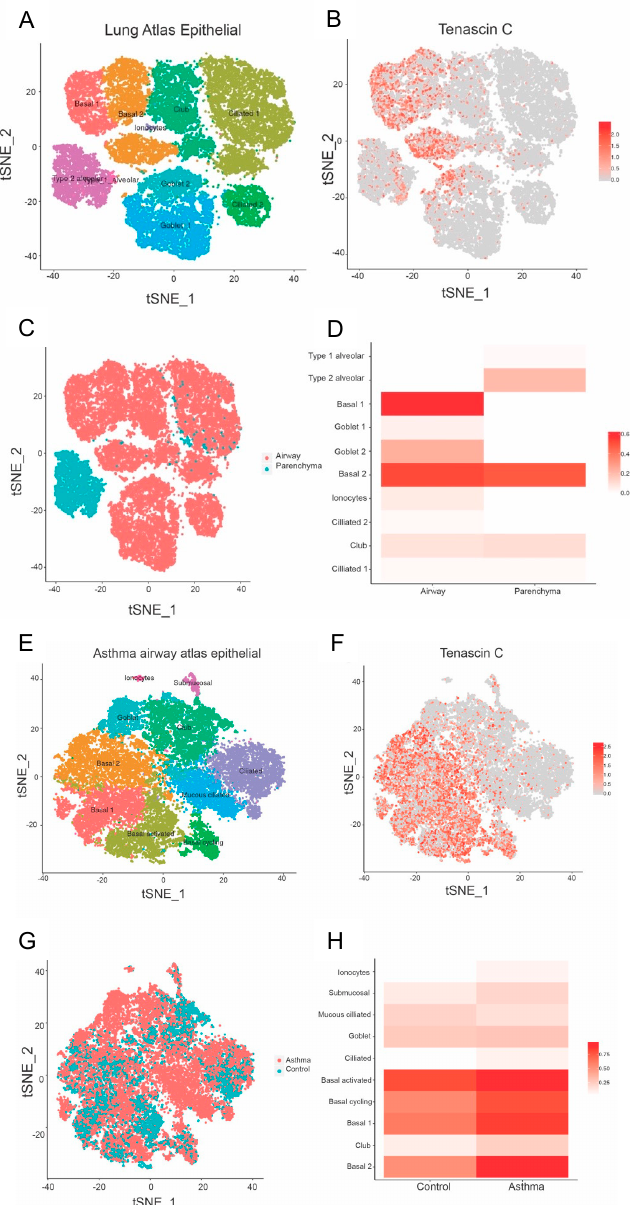
Figure 3. TNC expression is increased in basal epithelial cells compared to parenchyma in healthy airways, and in asthmatic samples compared to healthy controls. ( A – D ) Single-cell RNA sequencing clustering analysis in healthy samples generated from https://asthma.cellgeni.sanger.ac.uk/ (accessed on 1 Novmber 2022). ( A ) Data from the epithelial lung atlas showing lung cell distribution. ( B ) TNC distribution in different cells corresponding to lung atlas. ( C ) Type of lung cell distribution in airway and parenchyma. ( D ) TNC distribution in airway and parenchyma correlating to different cell types. ( E – G ) Single-cell RNA sequencing clustering analysis in asthma airway. ( E ) Asthma airway atlas epithelial showing abundance of different types of lung cell distribution in asthmatic patients. ( F ) TNC distribution in different epithelial cells in asthmatic patients. ( G ) Epithelial cell distribution in asthmatic and control patients. ( H ) TNC distribution in control and asthmatic